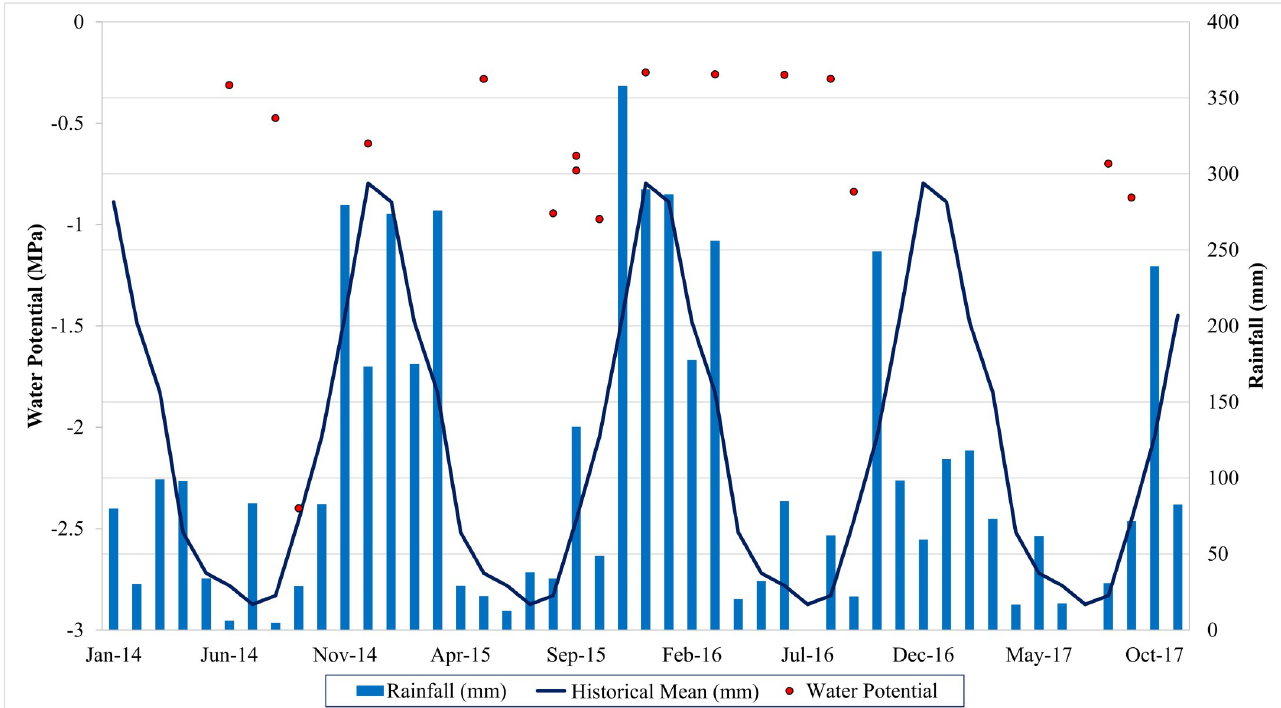
Fig 3. Variability of C w (MPa) values, total rainfall (mm), and average mean rainfall (mm), according to the meteorological station (Lavras, MG), from 2014 to 2017.